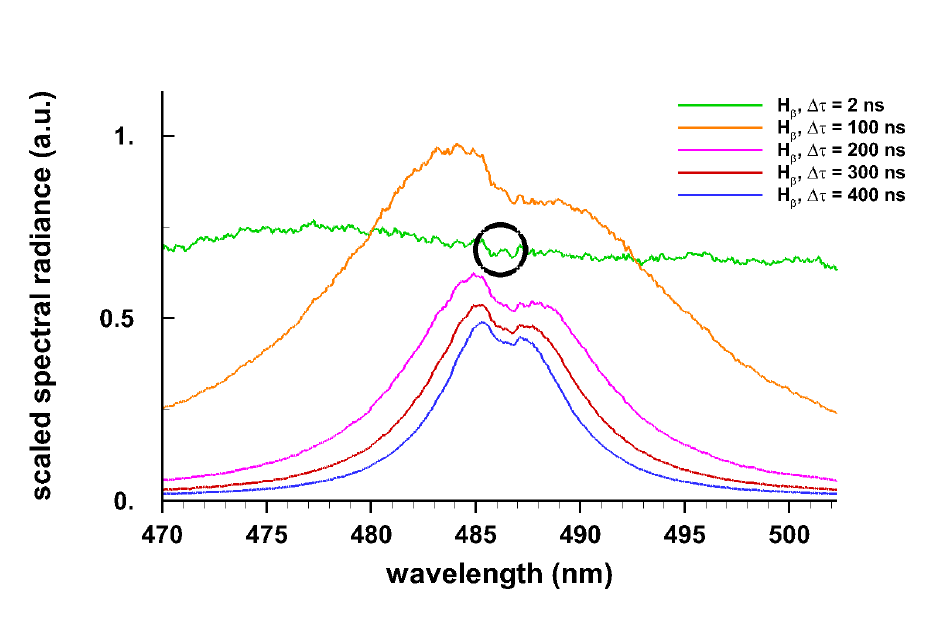
Figure 6. Line shapes of H β for the indicated time delays. The encircled area in the 2-ns time-delay data shows H β absorption, in other words, H β laser-plasma self-absorption.